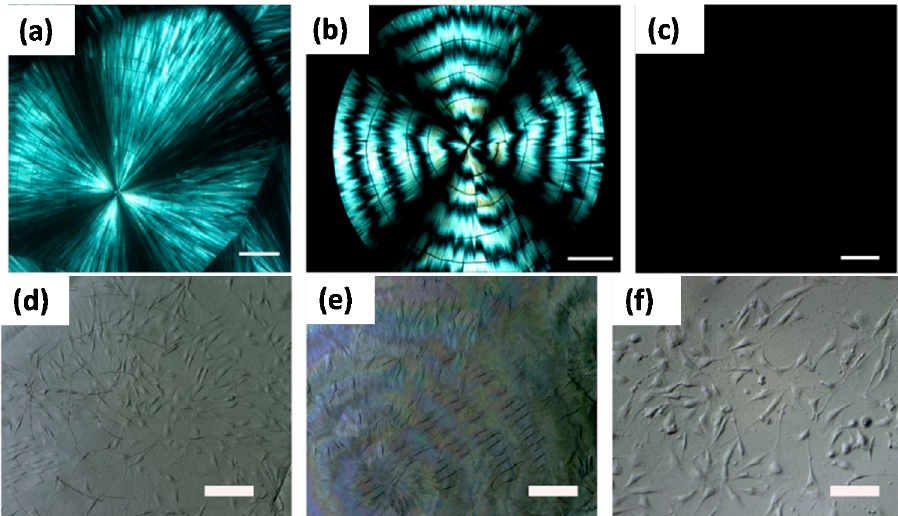
Figure 8. Polarized optical images of PLLA films crystallized at various crystallization temperature (T c ) values. ( a ) T c = 150 °C; normal spherulite surface ( b ) T c = 145 °C; ring-banded spherulite ( c ) melt-quenched sample; amorphous surface. The scale bar represents 100 μ m. Stereo microscope images of MC3T3-E1 cells cultured on PLLA surfaces; ( d ) normal spherulite surface; ( e ) ring-banded spherulite surface; ( f ) amorphous surface. The scale bar represents 100 μ m [60].